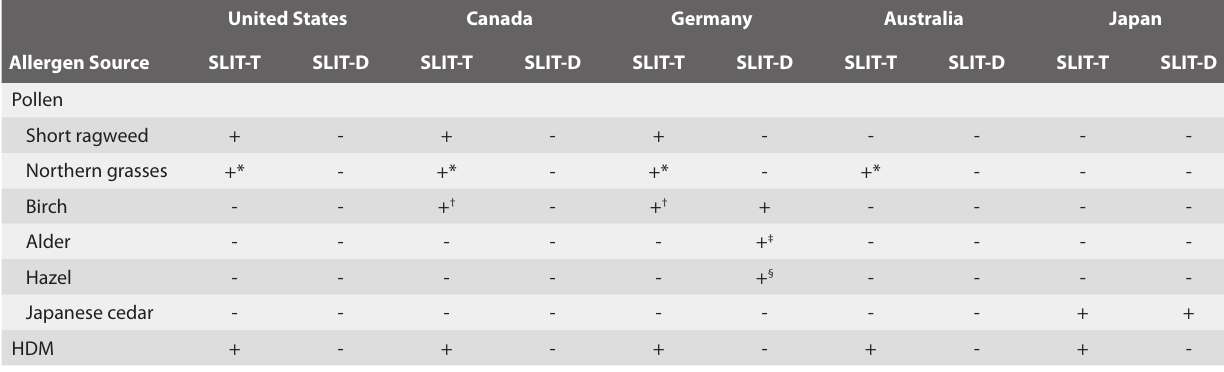
Table 1. Regulatory-approved SLIT-T and SLIT-D products in the United States, Canada, Germany, Australia, and Japan.